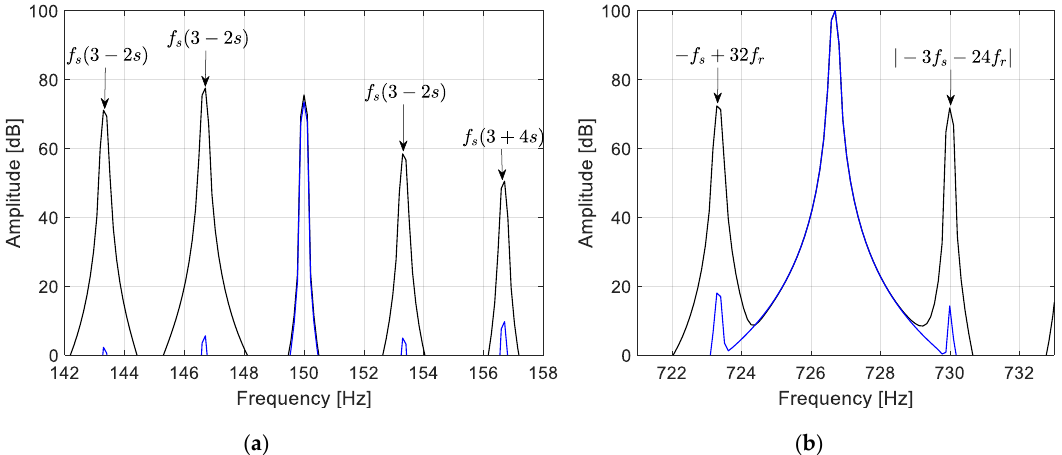
Figure 12. Comparison of ZSV spectra for the following cases: ( a ) symmetry (blue color) and ( b ) rotor cage fault (black color). Table 8. Results of harmonics amplitude measurements of the characteristic frequency for a given type of eccentricity, obtained from FEM simulations. Healthy (dB) Di ff erence (dB)